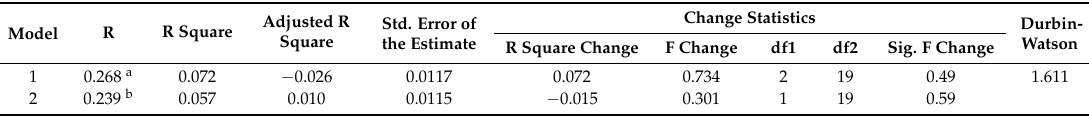
Table 6. Regression analysis statistics and models’ summary among reflectance values and total phosphorus concentrations (dependent